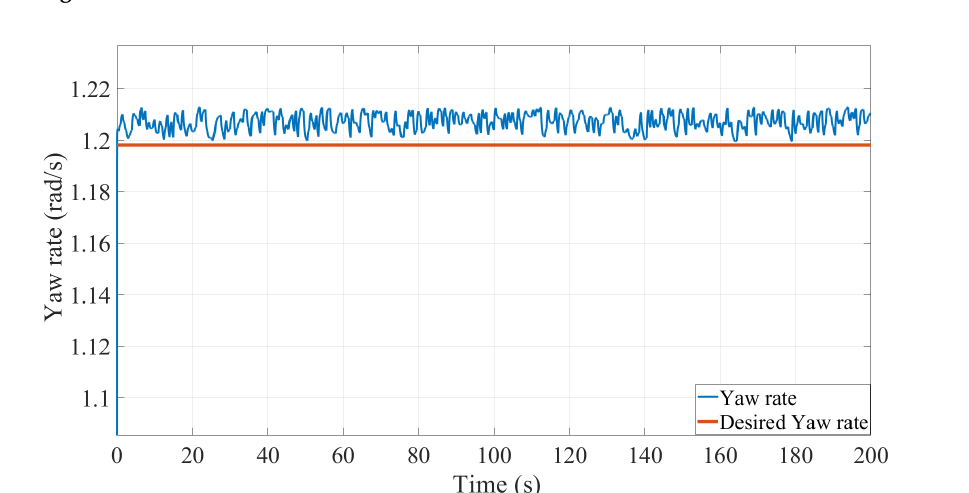
Figure 23. SMC with underestimated